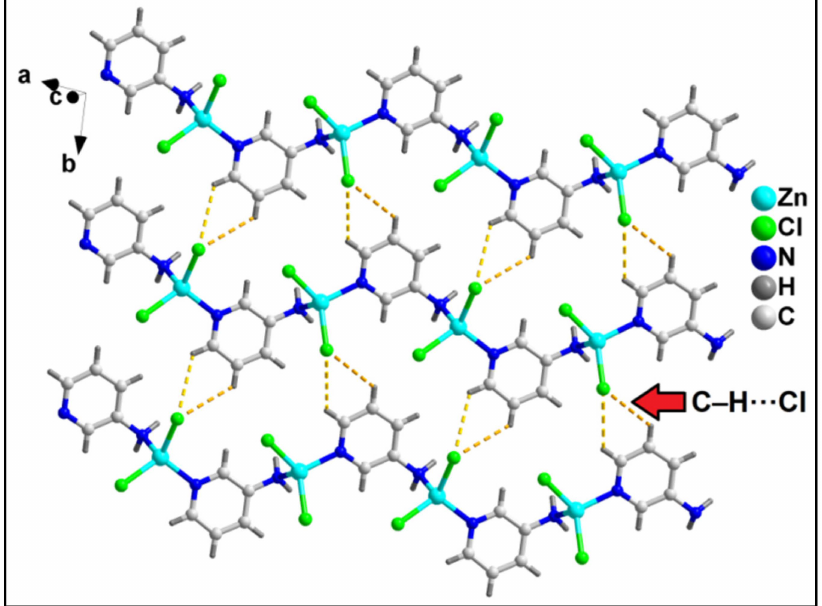
Figure 7. Layered assembly of compound 2 along the crystallographic ab plane involving C–H · · · Cl hydrogen bonding